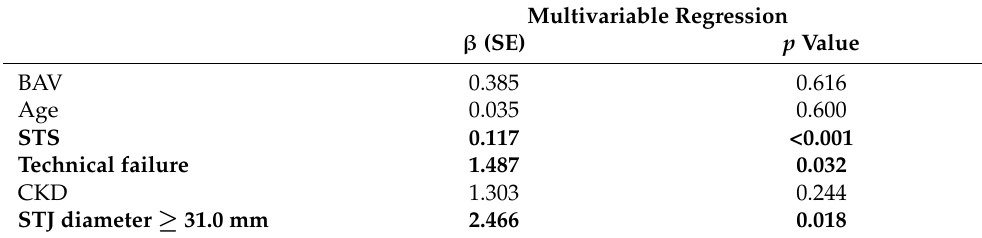
Table 6. Multivariate Cox regression analysis of 30-day all-cause mortality, using a Enter Method.